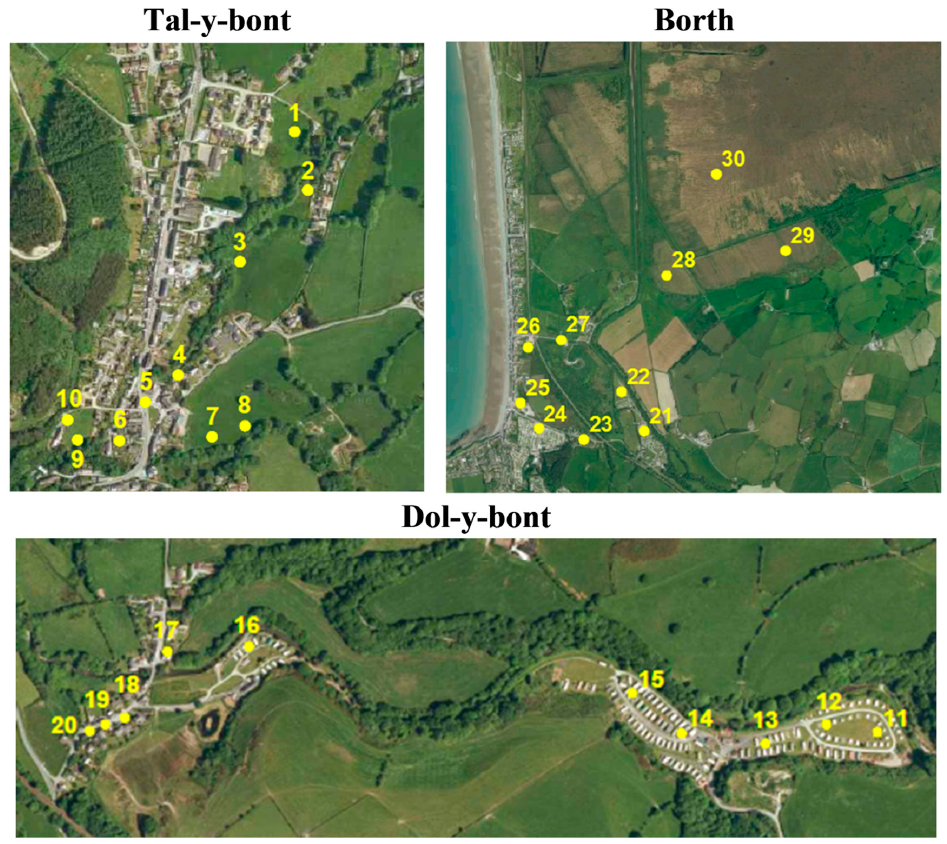
Figure 5. Approximate locations of the selected monitoring points around Tal-y-bont, Dol-y-bont and Borth (adopted from Google maps).